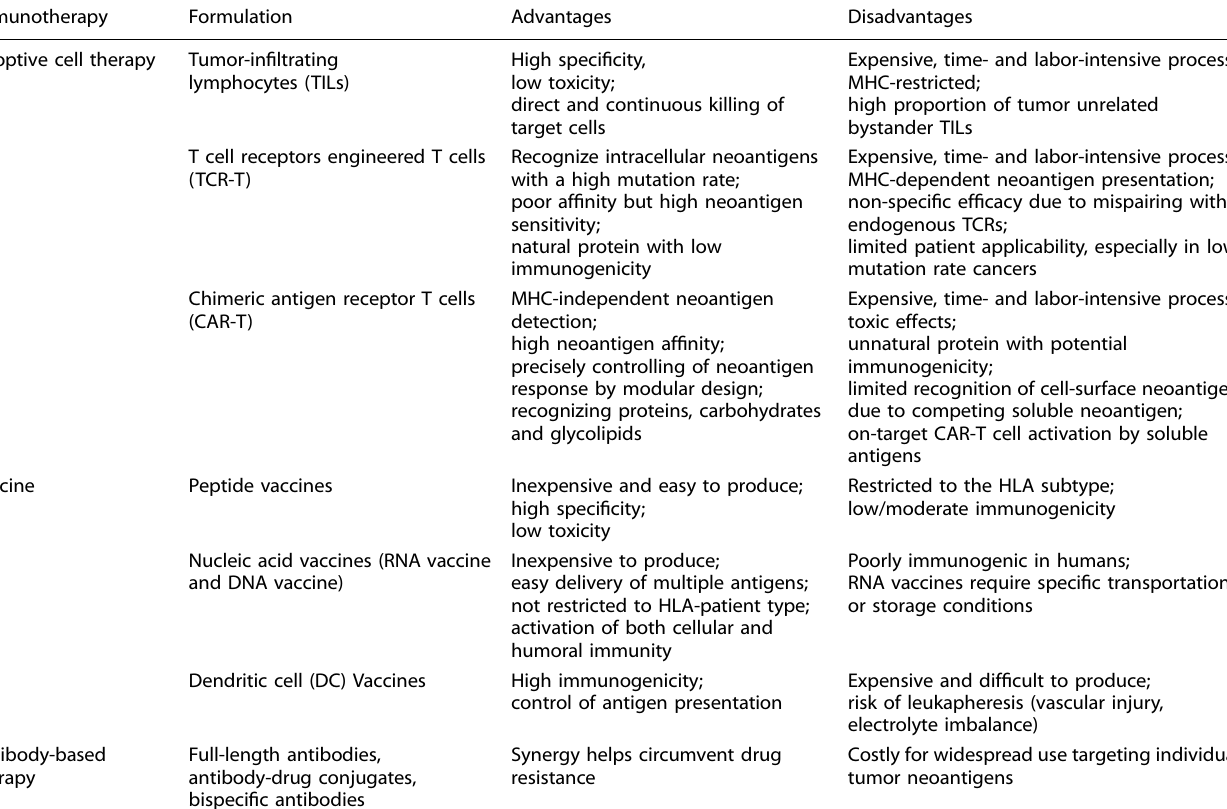
Table 3. Advantages and disadvantages for neoantigen-based immunotherapies